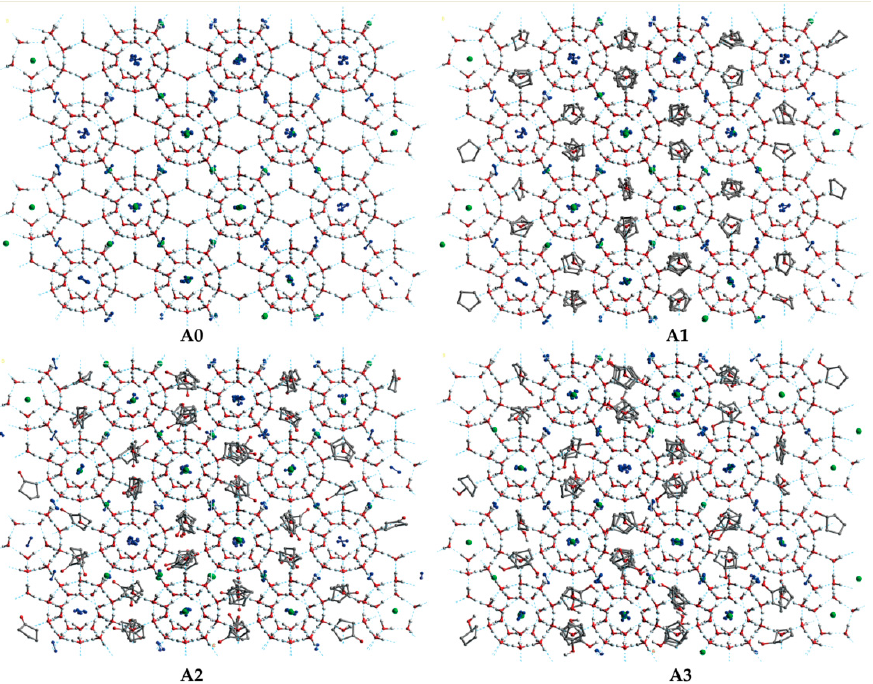
Figure 10. The initial structure of the ( A0 ), ( A1 ), ( A2 ), and ( A3 ) model. The gray, red, and white balls represent C, O, and H atoms, respectively. The green balls represent CH 4 molecules.